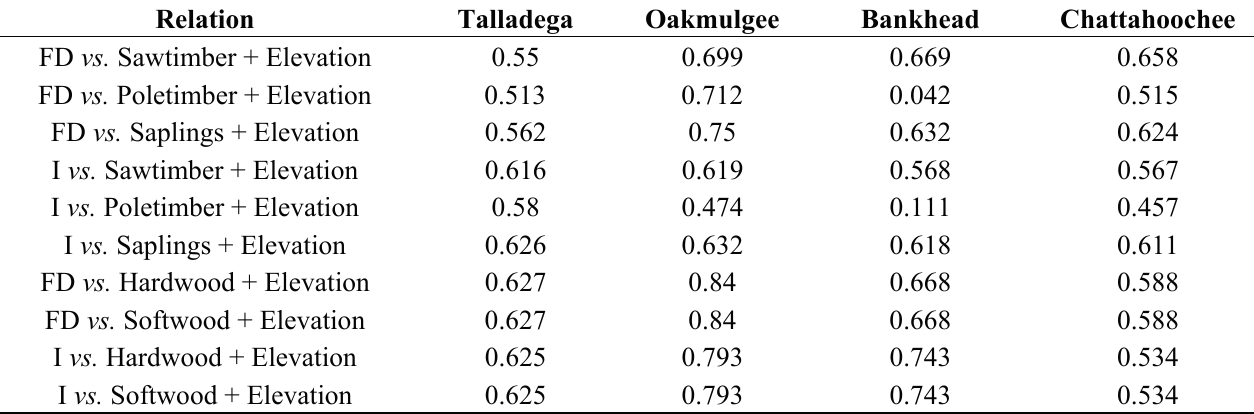
Table 5. R 2 of multiple regression including